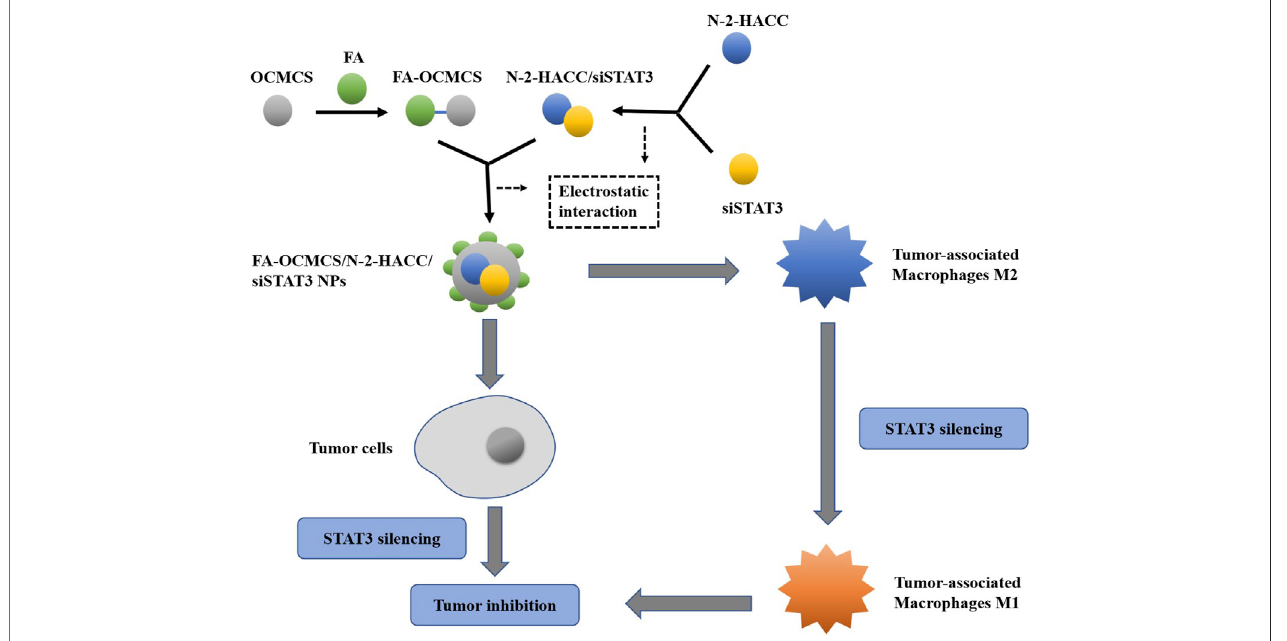
FIGURE5| TheconstructionoftheNPsanddual-targetingpathways.WithFAasthetargetligandandOCMCSasthedeliverycarriers,NPscanbeconstructedby electrostaticinteractiontoachievethetargeteddeliveryofsiSTAT3totumor-associatedmacrophagesM2.ByinhibitingtheexpressionofSTAT3,theNPscantransform M2 into M1 phenotype to inhibit tumor cells or directly deliver to tumor cells to induce